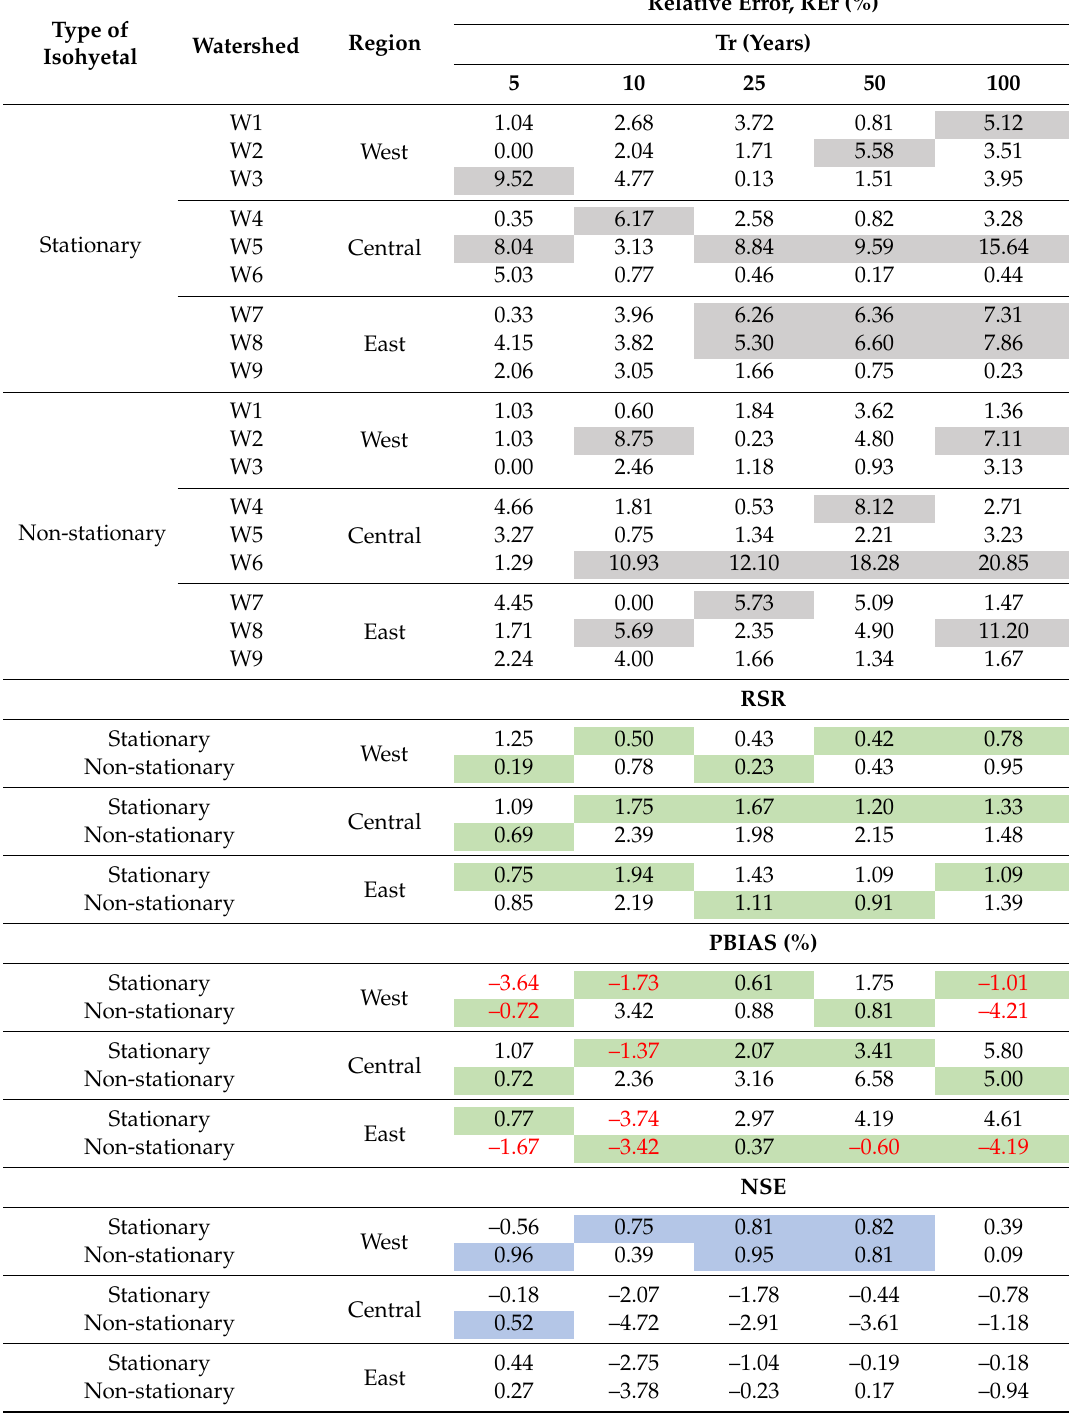
Table 11. Statistical analysis of isohyetal map